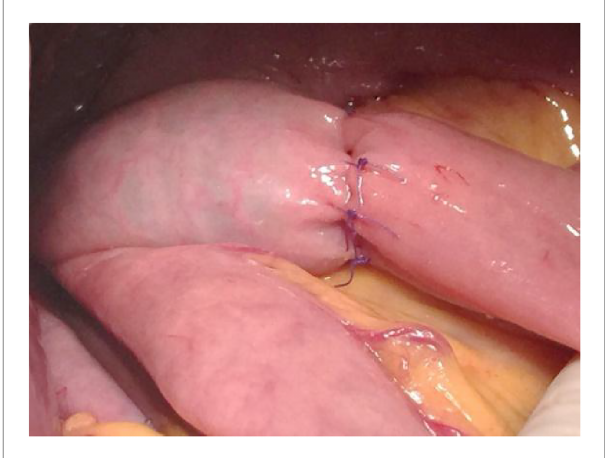
FIGURE 3 Reinforced by interrupted full-thickness sutures at the occlusion site.